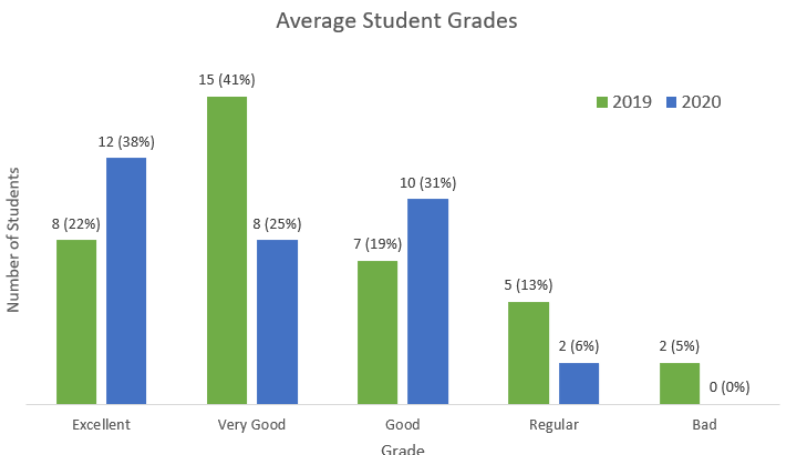
Figure 4. Comparison of face-to-face vs. remote